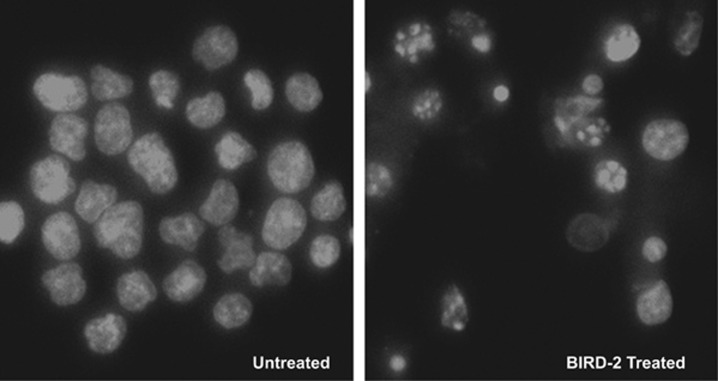
Morphological evidence of apoptosis induction by BIRD-2. H2171 SCLC cells were untreated (left) or treated for 48 h with 20 μM BIRD-2 (right). Nuclei were then stained with Hoechst 33342, which fluoresces when bound to dsDNA. The nuclei of Scr-treated cells display a normal heterochromatin pattern, while the nuclei of many BIRD-2-treated cells display chromatin condensation and apoptotic bodies typical of cells undergoing apoptosis